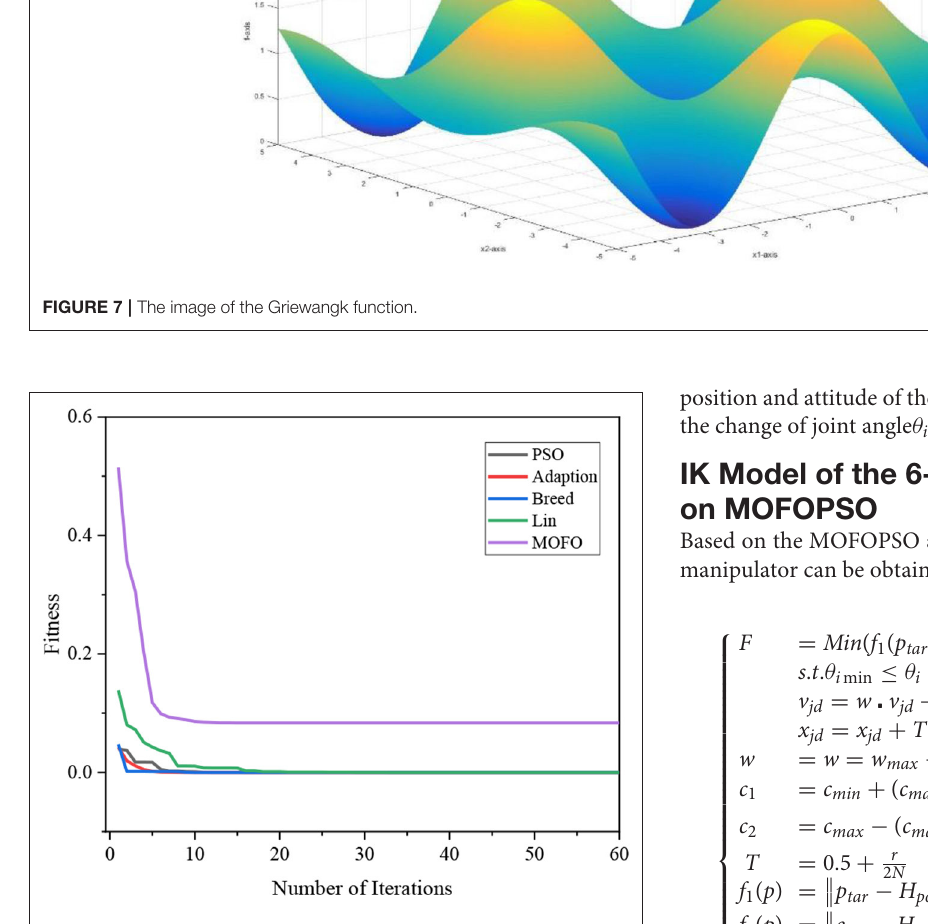
FIGURE 8 | The abilities of the algorithms to jump out of the local optimal.